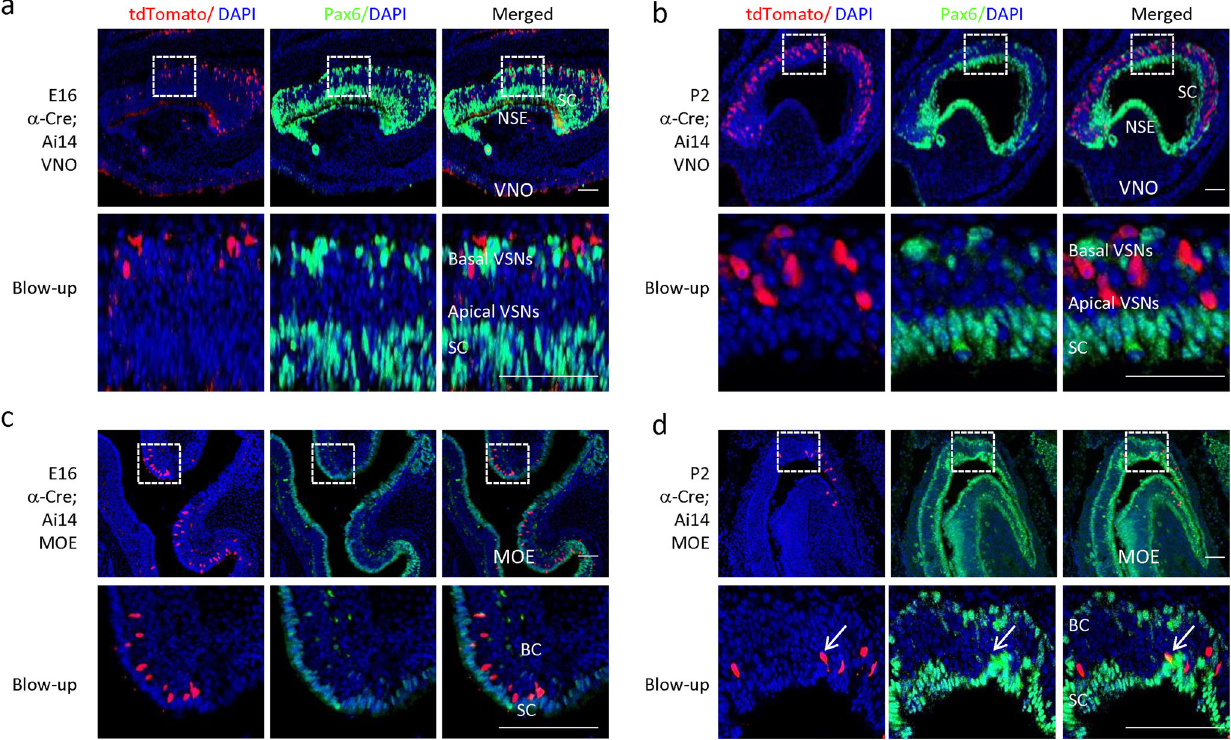
Fig. 6 α -Cre does not colocalize with Pax6 in the olfactory system. Coronal VNO ( a , b ) or MOE ( c , d ) sections of E16 or P2 α -Cre;Ai14 mouse stained for Pax6 (green), tdTomato (red) and nucleus (blue). Selected areas are blown up to show the colocalization between Pax6 and tdTomato (dotted white box). White arrows in d indicate one Pax6 + and tdTomato + cell. VNO, Vomeronasal organ; MOE, main olfactory sensory epithelium; NSE, non-sensory epithelium; SC, sustentacular cells; BC, Basal cells; VSNs, vomeronasal sensory neurons. Scale bar: 100 µ m.